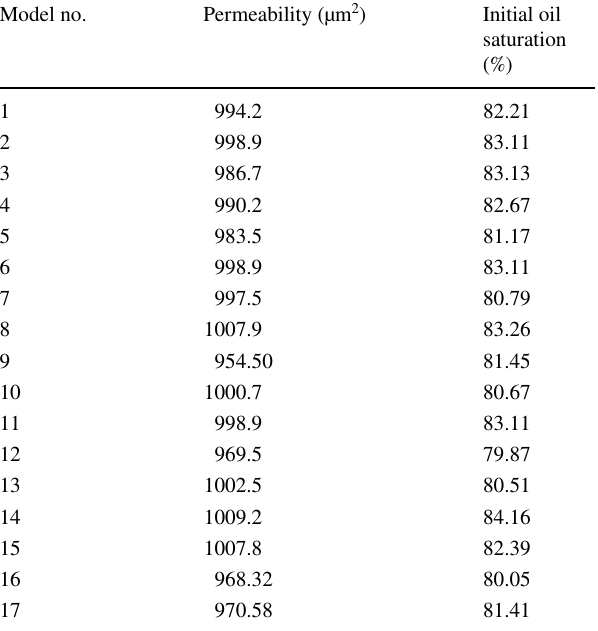
Table 1 Parameters of sandpack models Model